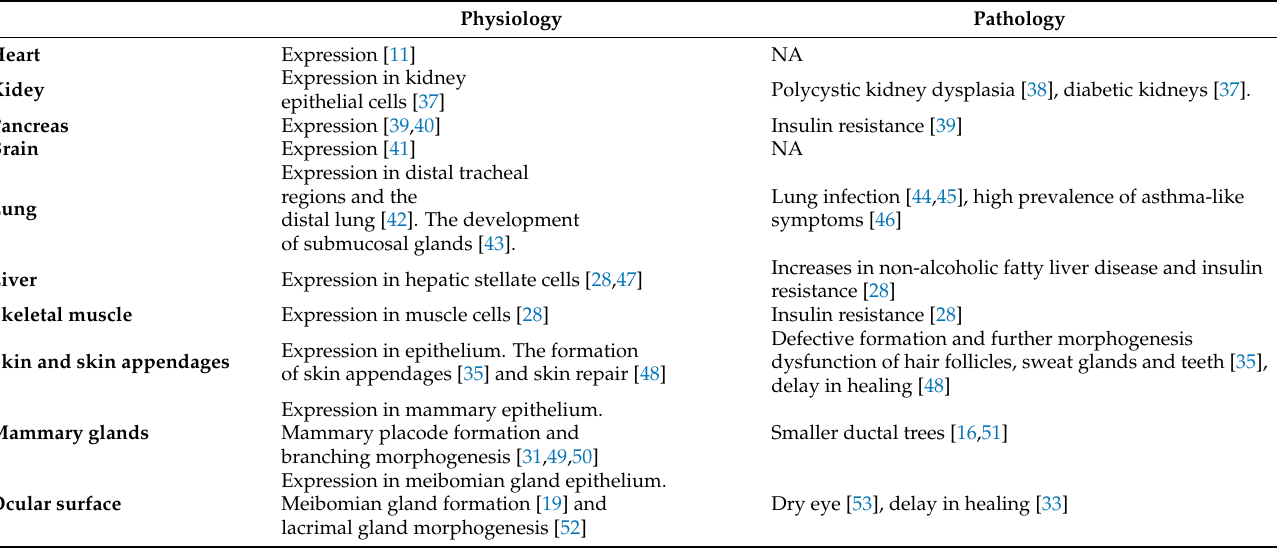
Table 1. Function of EDA in organs and